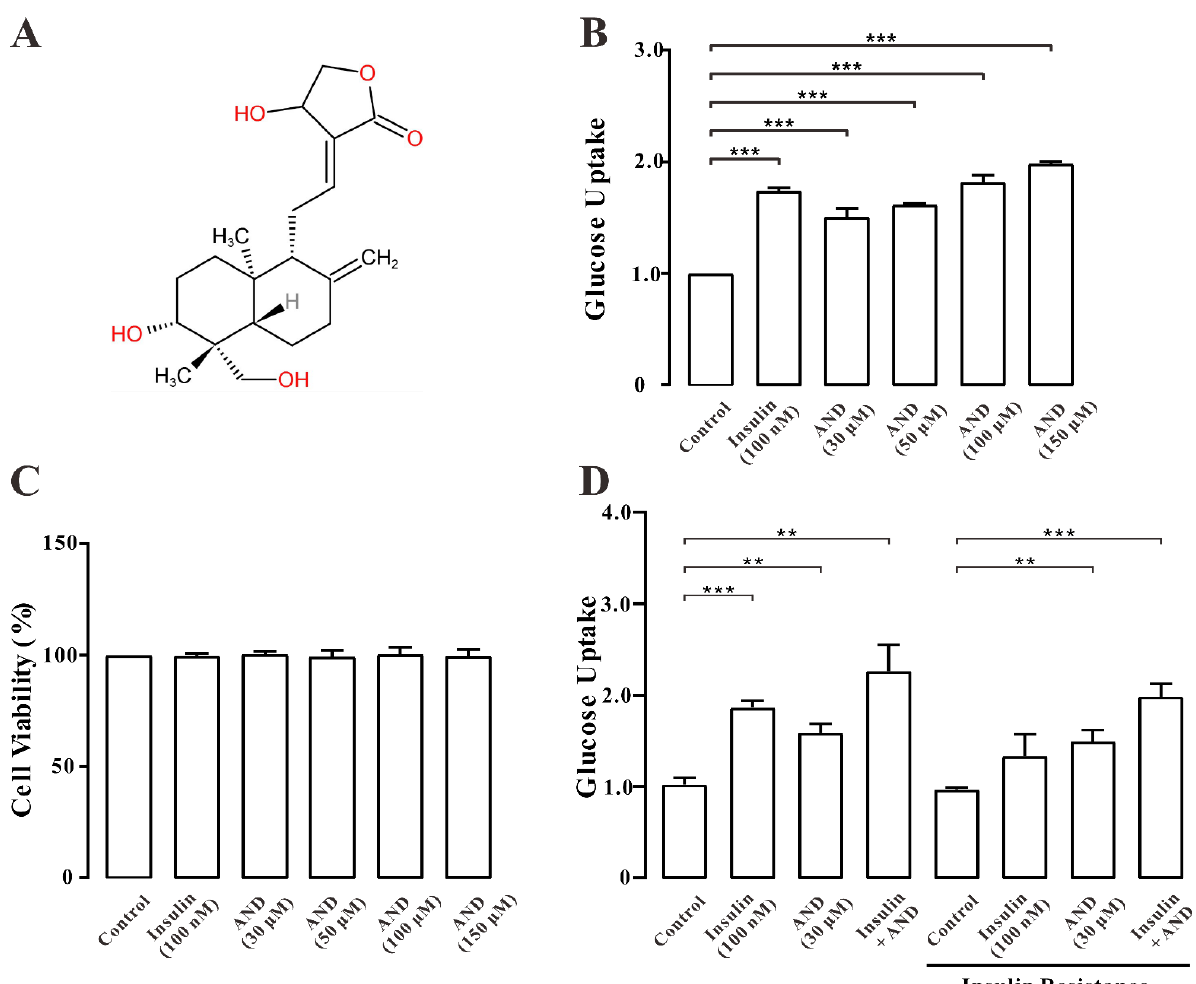
Figure 4. AND promoted the uptake of glucose in L6 cells. ( A ) Chemical structure of AND. ( B ) Values on the Y-axis represent the fold relationship of glucose uptake by L6 cells compared with that in normal conditions. Uptake of glucose in L6 cells under the incubation of AND or insulin, the data represent the mean ± s.e.m. of values from three separate experiments. ( C ) Toxicity of AND to L6 cells, the data represent the mean ± s.e.m. of values from three separate experiments. ( D ) Values on the Y-axis represent the fold relationship of glucose uptake by L6 cells compared with that in normal conditions. Uptake of glucose in L6 cells induced by AND in insulin-resistant L6 cells, the data represent the mean ± s.e.m. of values from three separate experiments. **: p < 0.01; ***: p < 0.001.